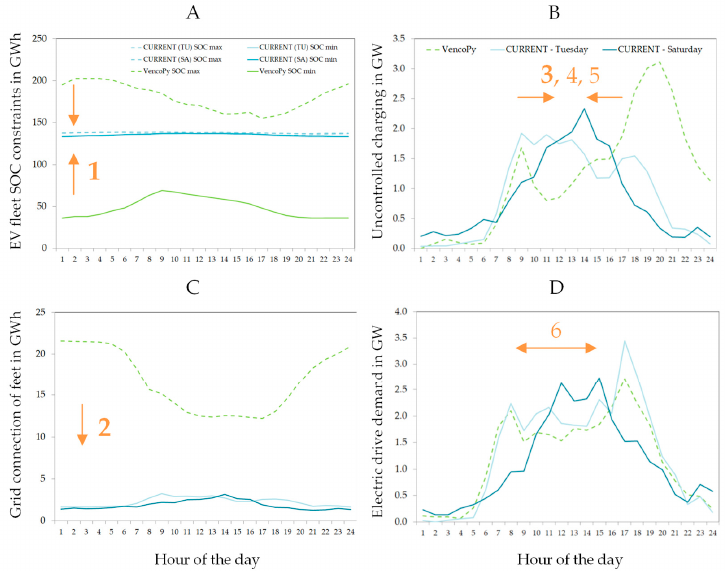
Figure 4. EV profiles for the case of a power system-oriented charging approach (VencoPy, green lines) and a user-behavior-oriented charging approach (CURRENT, turquoise lines) for the case of medium-sized BEV in Northern Germany. Arrows and numbers illustrate the effects of structural differences given in Table 7. CURRENT profiles are given for a working day (TU: Tuesday, light turquoise) and a weekend day (SA: Saturday, darker turquoise). ( A ) SOC min and max profiles. Dashed lines give maximum SOC and solid lines minimum SOC. ( B ) Uncontrolled charging profiles.